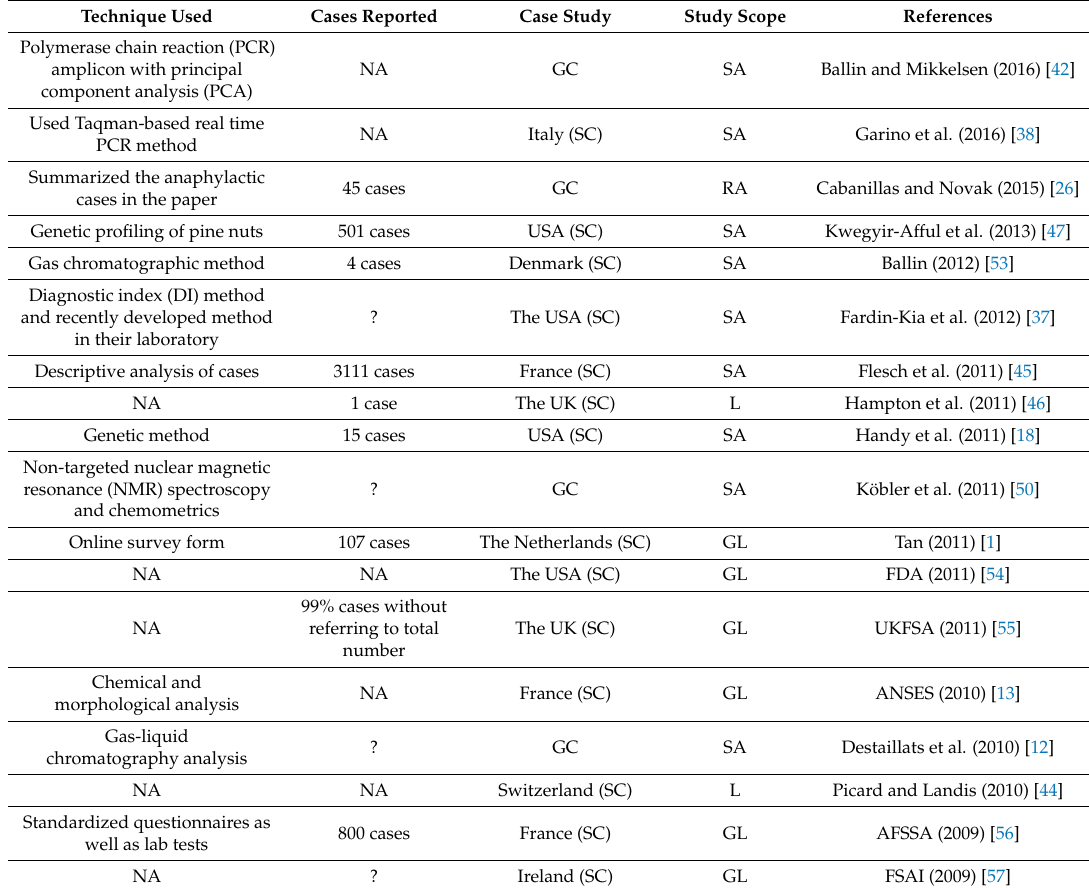
Table 5. Summary of PNS